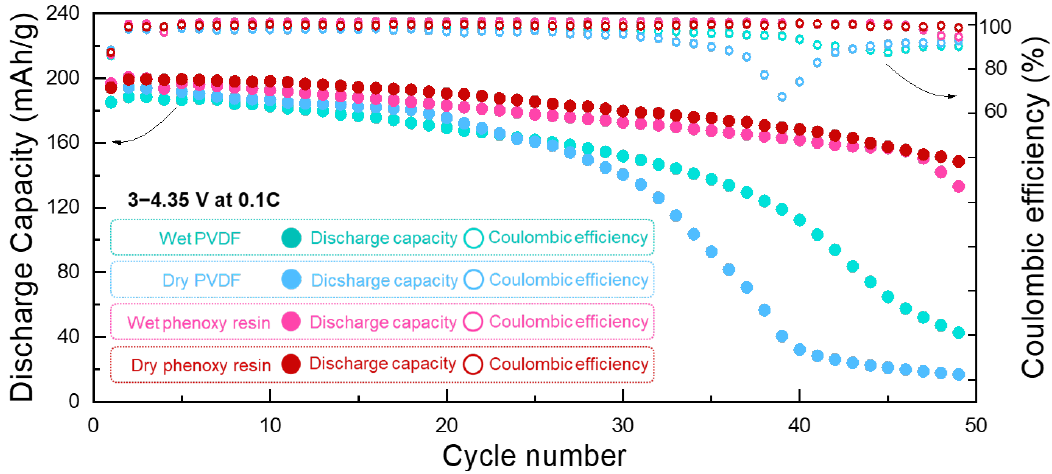
Figure 6. Cross-sectional SEM image and EDS mapping of electrode surface of ( a ) wet PVDF, ( b ) dry PVDF, ( c ) wet phenoxy resin, and ( d ) dry phenoxy resin. Scale bar = 50 μm. Ni and C elemental distribution are indicated by cyan and red, respectively.